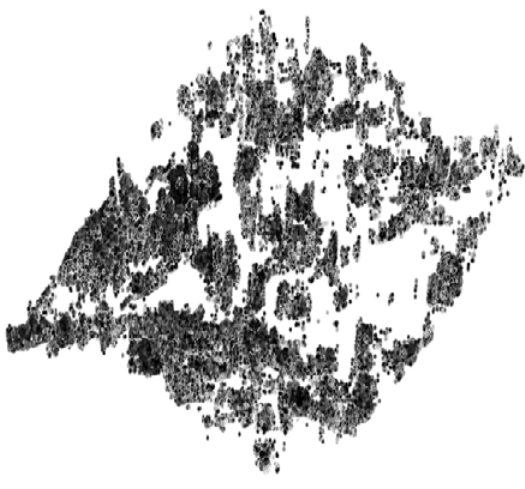
Figure 12. Trees extracted based on multiple